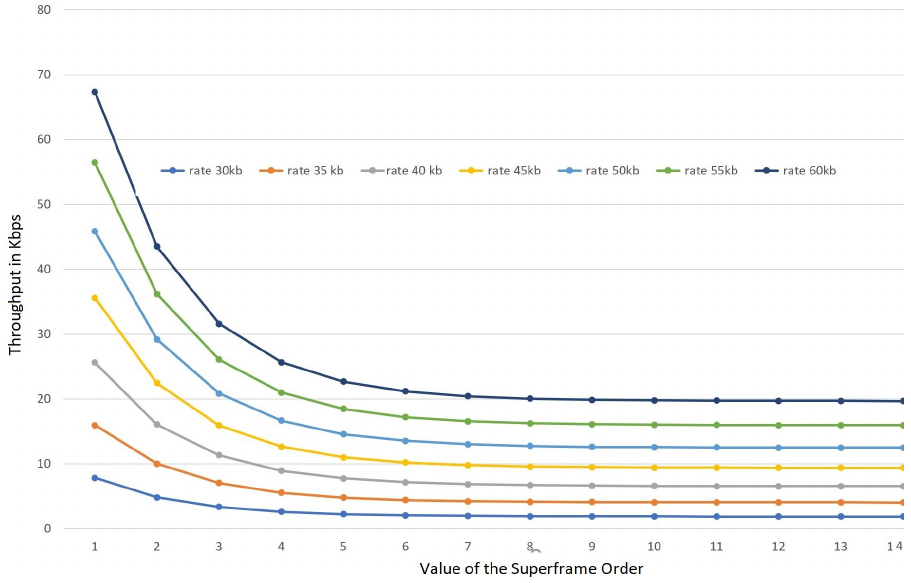
Figure 7. Maximum throughput of a Guaranteed Timeslots (GTS) allocation as a function of ar- rival